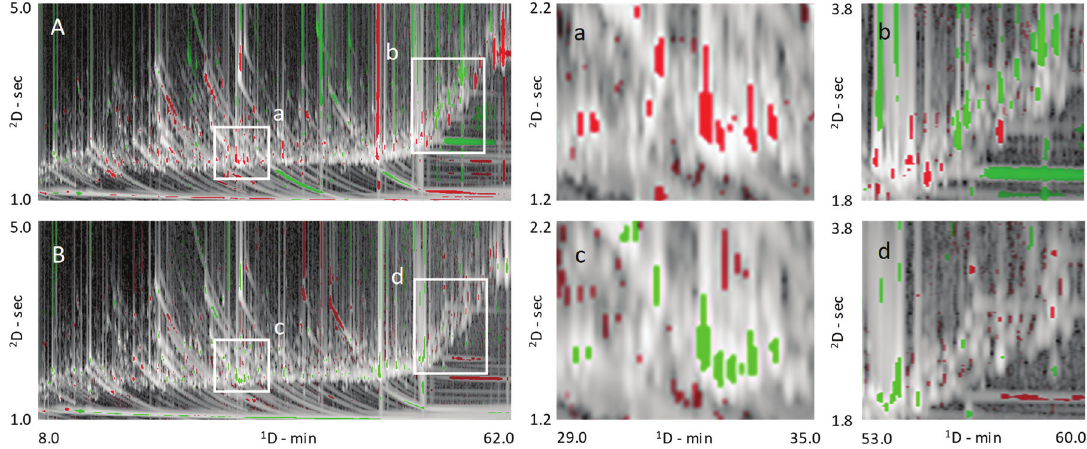
Figure 4. Pair-wise comparison based on visual features fingerprinting [7], the comparative visualization is rendered with a colorized fuzzy difference. Pixels brightness indicates the magnitude of the absolute response; pixels hue indicates whether the analyzed image (i.e., 2015_YUN_HS in ( A ) or 2015_FUJ_LS in ( B )–green) or reference image (i.e., 2015_FUJ_HS for both visualizations-red) has the higher response value. Pixel saturation (color vs. grey tones) indicates the magnitude of the difference between the analyzed and reference images, with grey indicating equal pixel values and bold colors indicating large differences. Enlarged areas, corresponding to white rectangles, highlight absolute compositional differences for monosaccharides (a/c) and of some secondary metabolites belonging to the chlorogenic acid and flavan-3-ol classes (b/d).